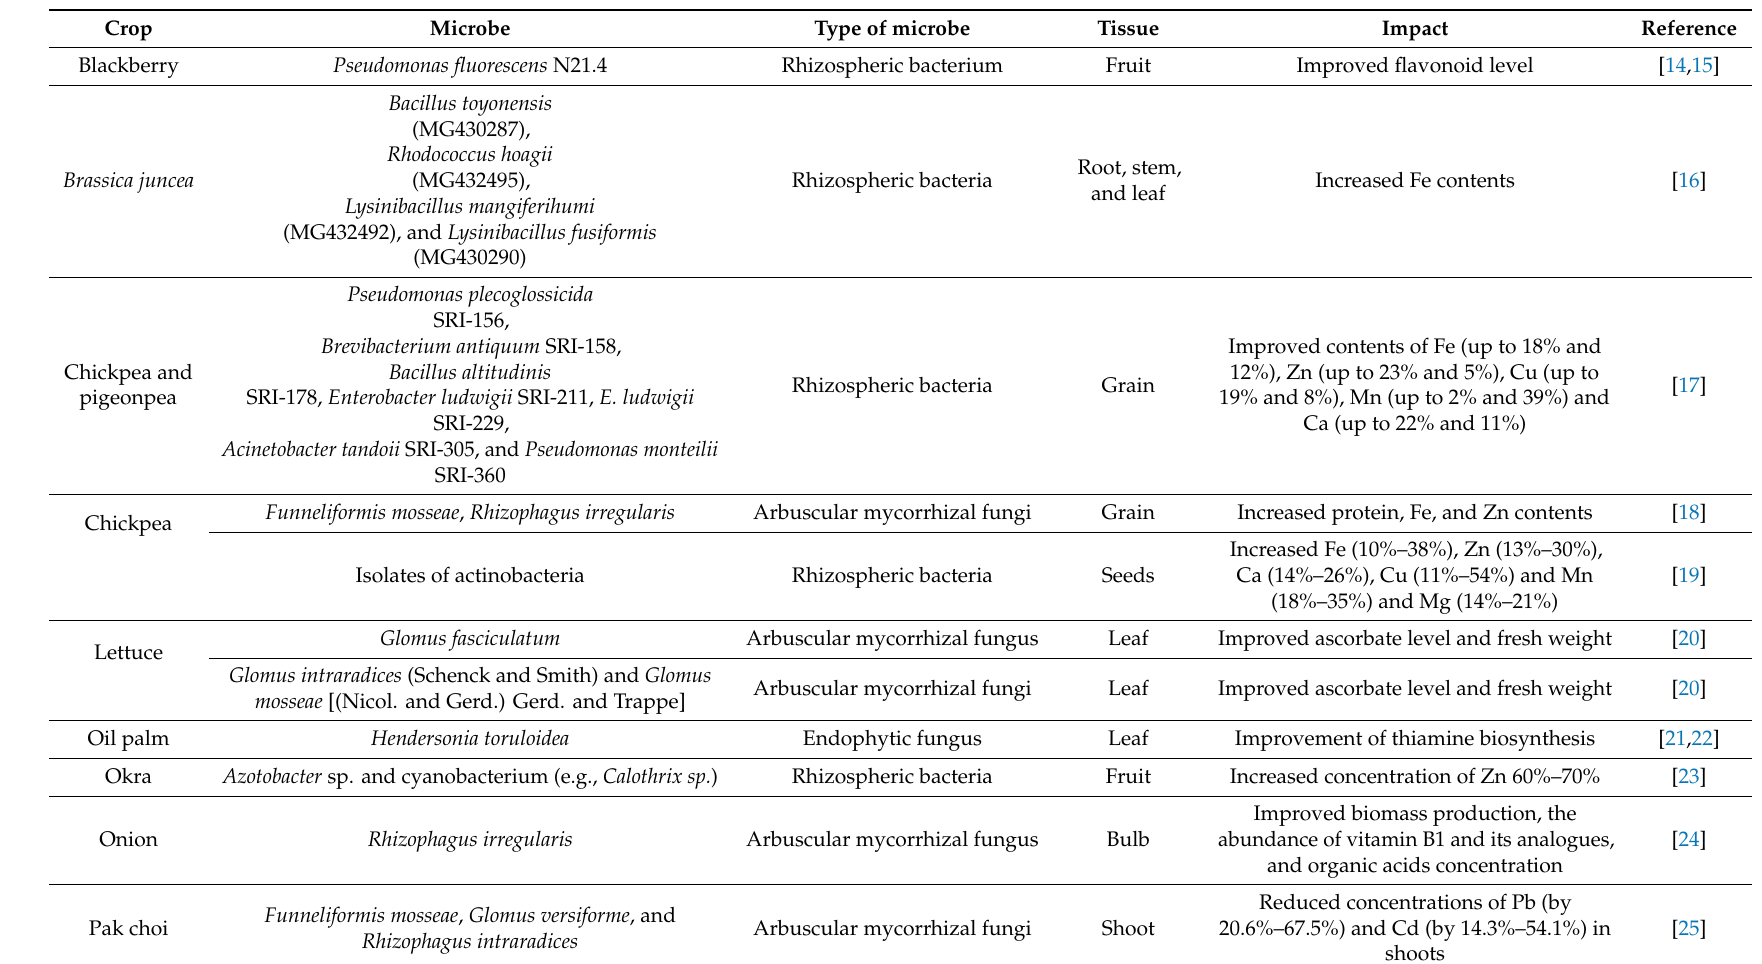
Table 1. Current examples of microbe-mediated biofortified